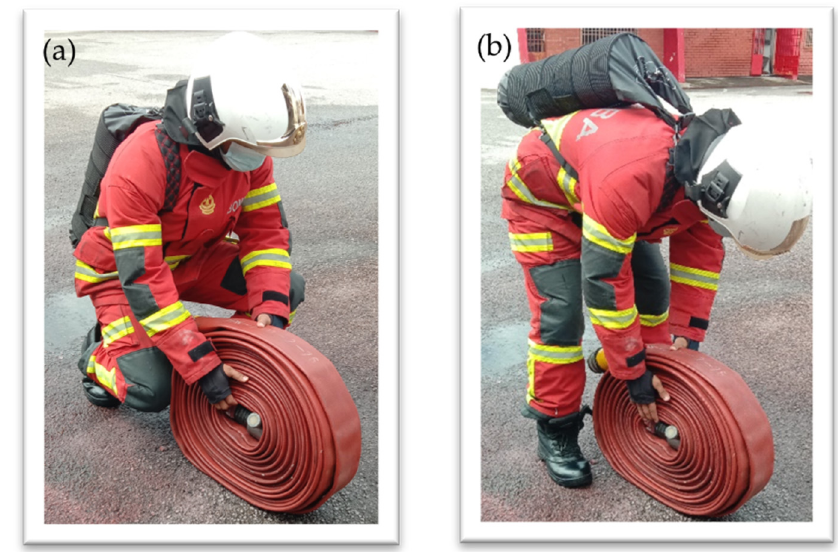
Figure 3. Type of ground lifting posture observed. ( a ) Squatting and ( b ) stooping.